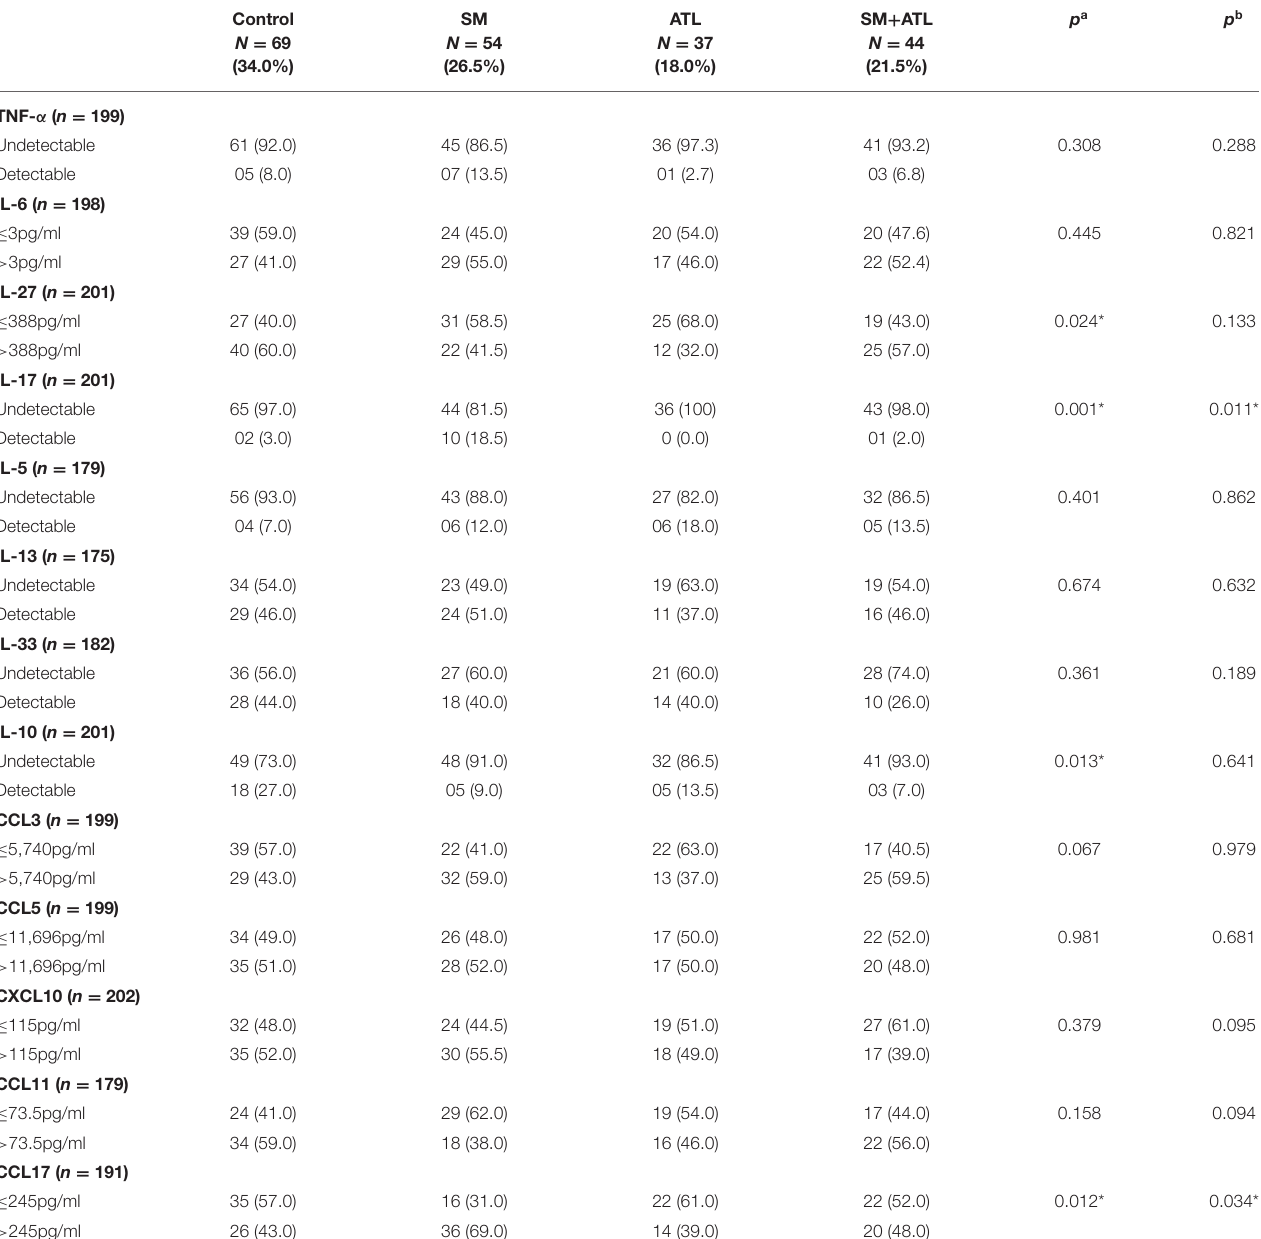
TABLE 5 | Frequency of serum samples with detectable levels of TNF- α , IL-17, IL-5, IL-13, IL-33, and IL-10, or with high levels of IL-6, IL-27, CCL3, CCL5, CXCL10, CCL11, and CCL17 from individuals with different parasitic infection profiles living in the rural community of Brejo do Amparo, Januária, Minas Gerais,